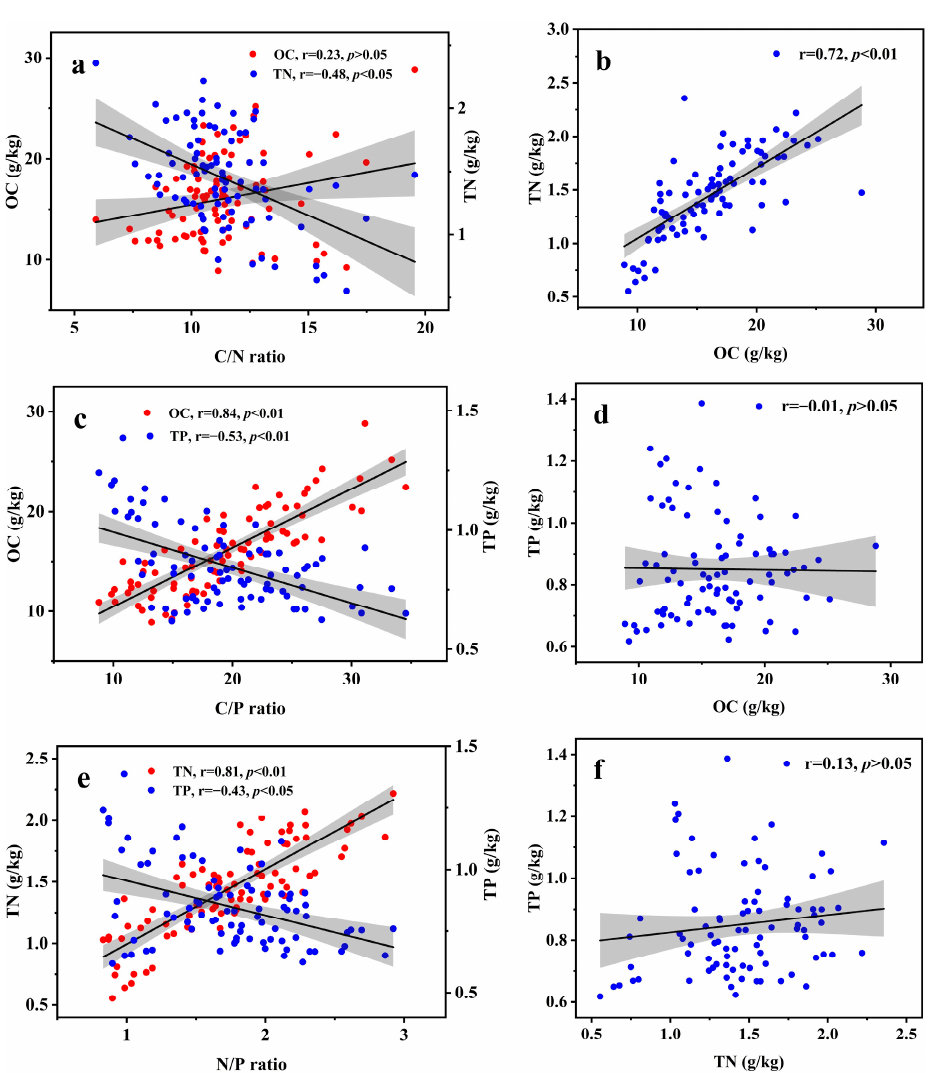
Figure 5. Linear correlations between soil nutrients and eco-stoichiometric ratios ( a – c ) and interaction relationships of various nutrients ( d – f ). OC, organic carbon; TN, total nitrogen; TP, total